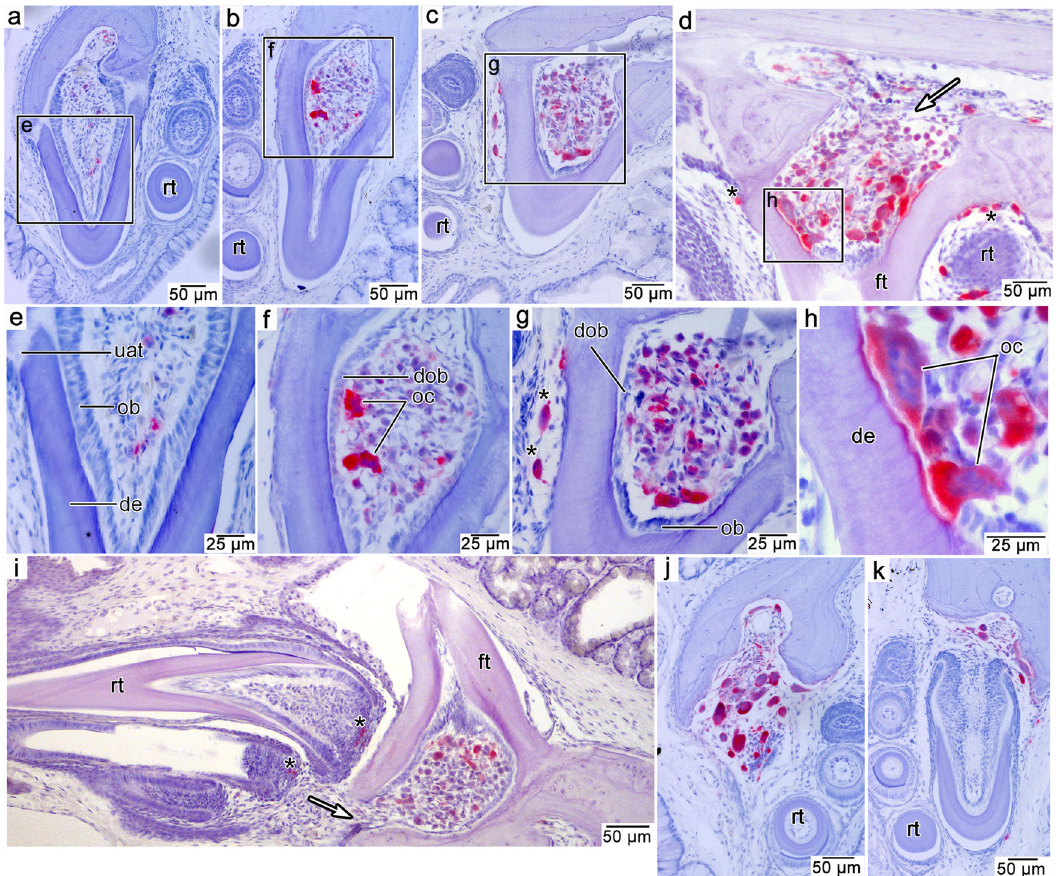
Fig. 1 | TRAP-stained sections of the tooth replacement cycle in a corn snake ( Pantherophis guttatus ). TRAP-positive odontoclasts stain red. Sections are counterstainedwithhematoxylinandeosin. a Attachmentstageinapalataltooth incoronalsection. b Ankylosisstageinamaxillarytooth. c Pre-resorptionstagein a maxillary tooth. d Early resorption stage in a palatal tooth in parasagittal sec- tion. White arrow indicates a potential entry point for odontoclast precursors. e Closeup of the dental pulp in a showing columnar odontoblasts and absence of odontoclasts. f Closeup of dental pulp in b showing shorter, degenerating odontoblasts and multinucleated odontoclasts. g Closeup of dental pulp in c